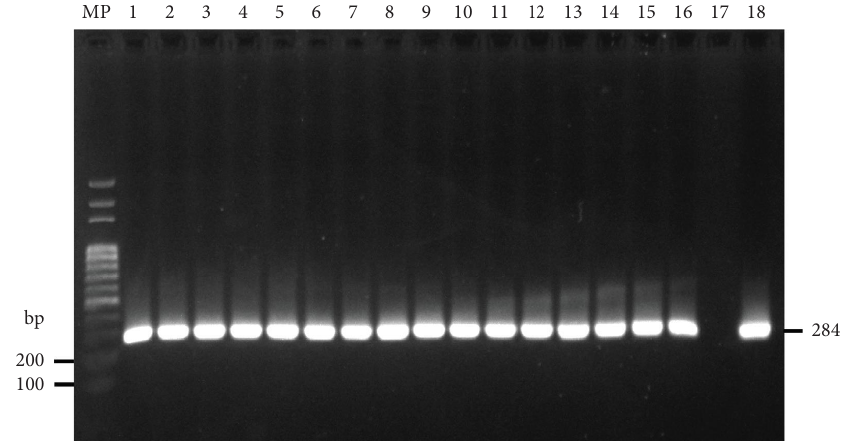
Figure 1: Gel image of the PCR amplifcation of a DNA fragment from the invA gene (284 bp) of representative Salmonella strains isolated from broiler farms. MP-100bp DNA ladder (Solis BioDyne, Estonia); 1–4: S . heidelberg ; 5–9: S . paratyphi B; 10: S . newport ; 11-12: S . enteritidis ; 13: S . braenderup ; 14: S . uganda ; 15: S . grupensis ; 16: S . typhimurium ; 17: negative control E. coli ATCC 25922; 18: positive control S . enteritidis ATCC